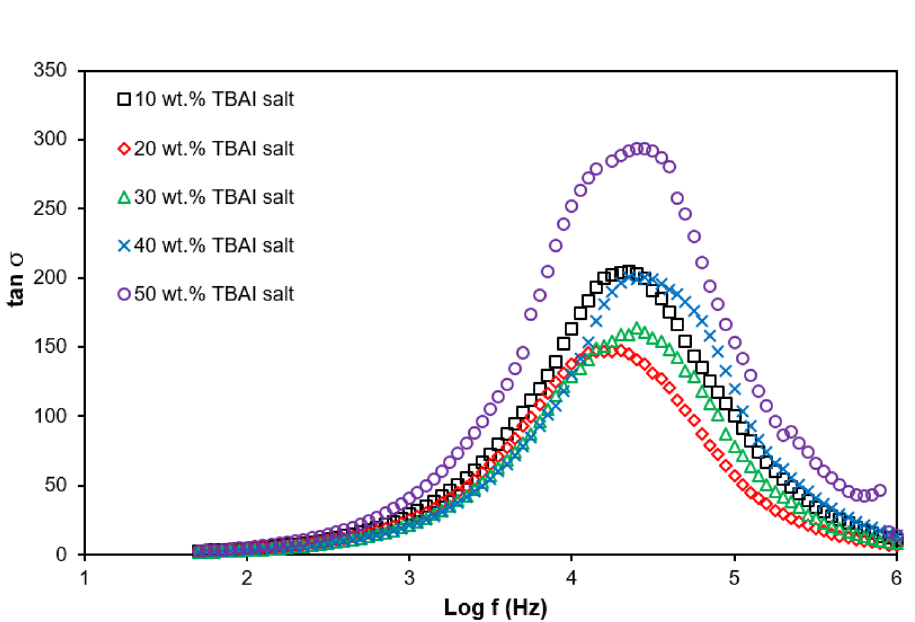
Figure 12. tan σ versus log frequency for PUA-TBAI-I 2 GPE system at room temperature (298